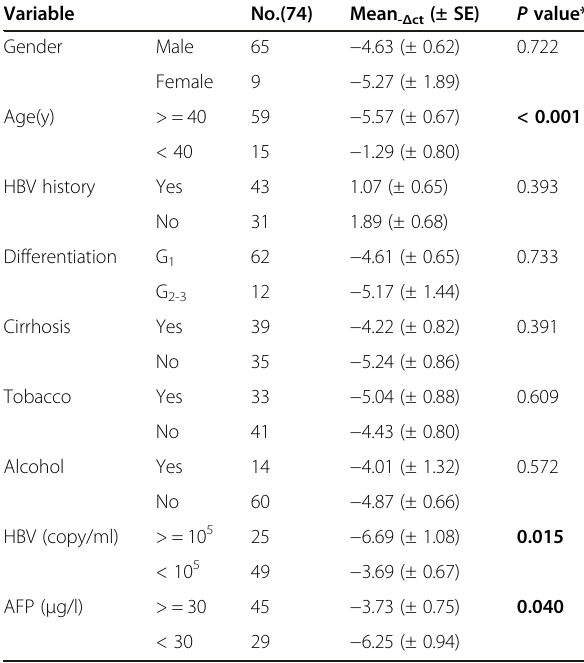
Table 1 Correlation of clinicophthologic variables with MUC2 mRNA in HCC